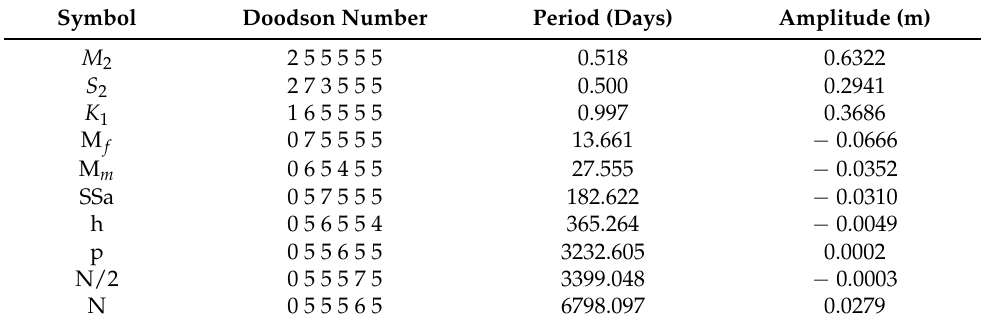
Table 1. Largest tidal